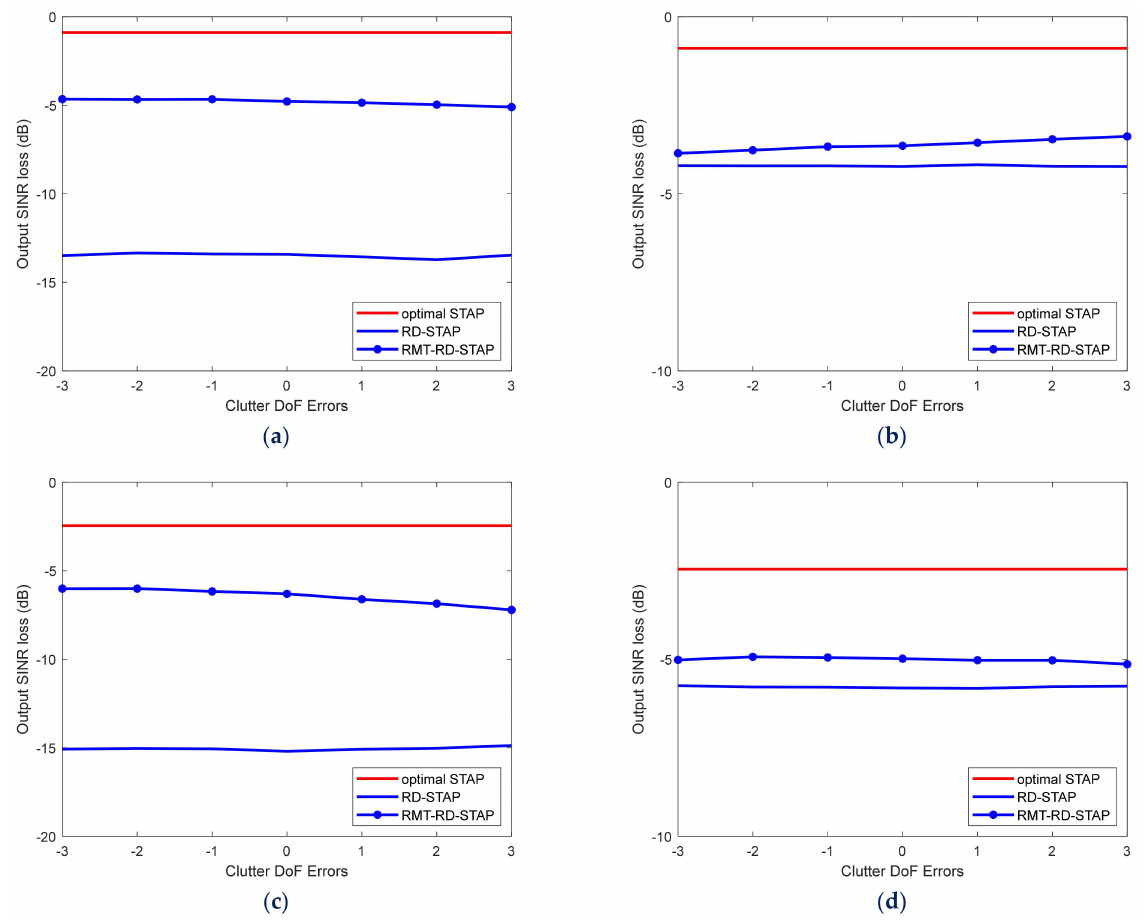
Figure 7. Output SINR losses versus clutter DoF errors. ( a ) V = 150 m/s, L = M ; ( b ) V = 150 m/s, L = 2 M ; ( c ) V = 300 m/s, L = M and ( d ) V = 300 m/s, L = 2 M